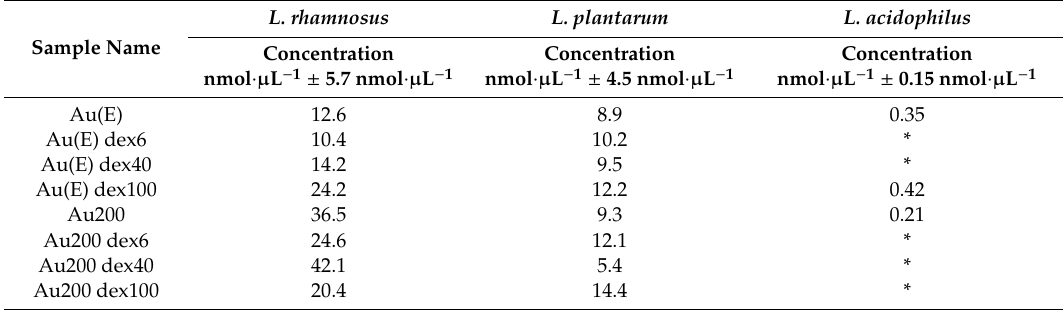
Table 2. The average concentration of lactic acid (nmol·L − 1 ) depending on the substrate and polymer after 24 h of cultivation of lactic acid bacteria strains.